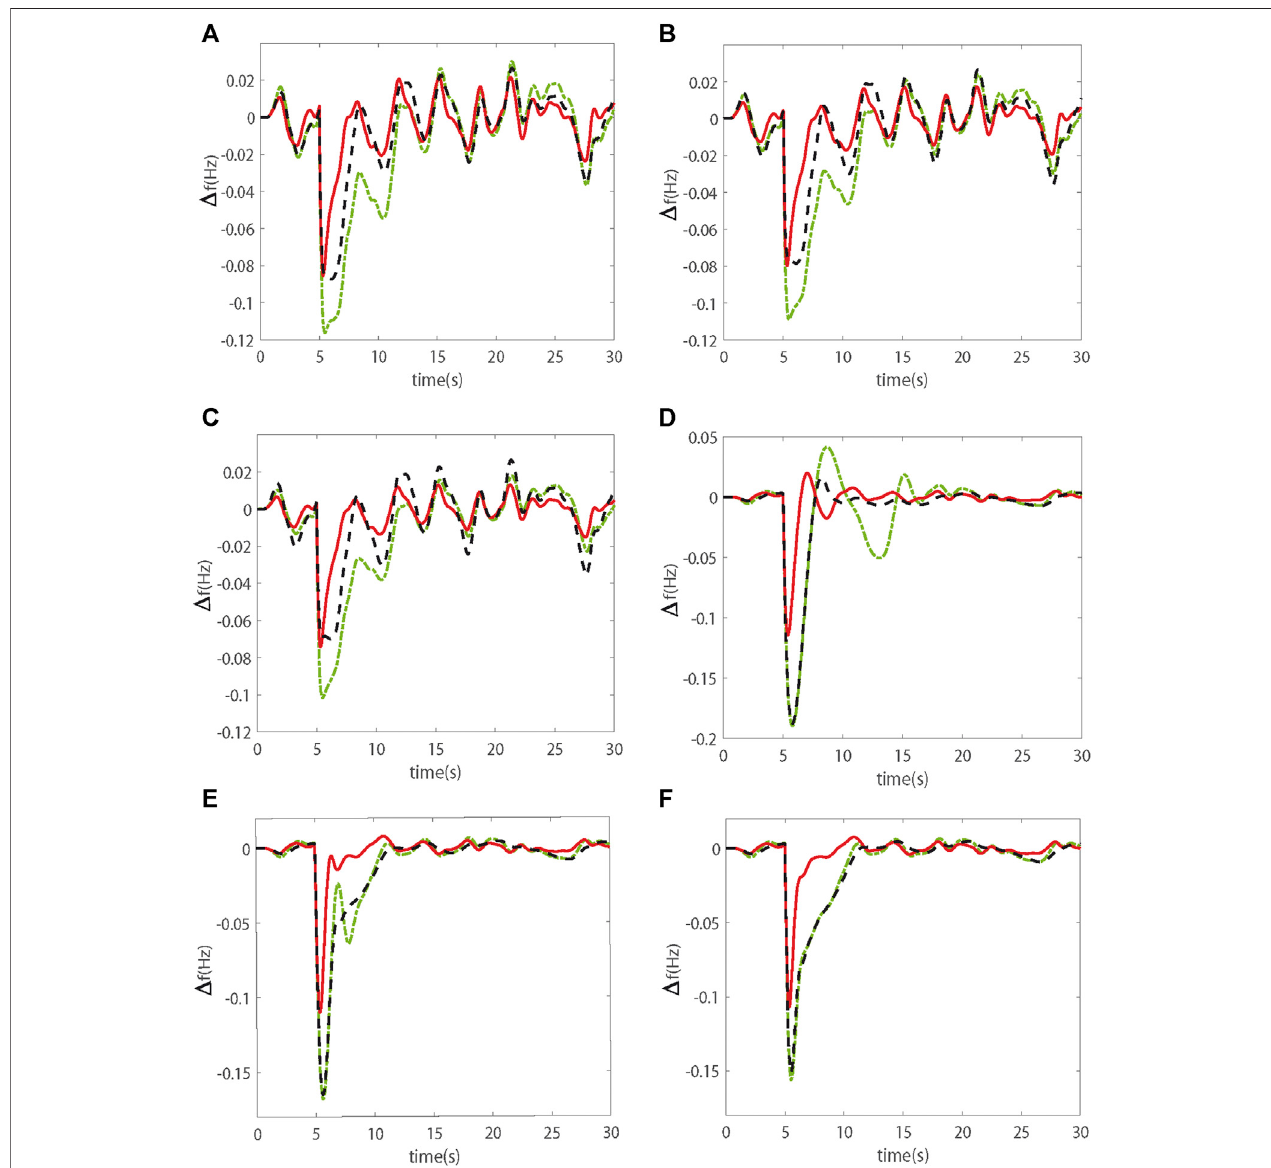
FIGURE3| Frequencydeviationfromdifferentcontrolmethods underthree scenarios invariable lowandhigh windspeed, (A) isScenario1inlowwindspeed, (B) is Scenario 2 in low wind speed, (C) is Scenario 3 in low wind speed, (D) is Scenario 1 in high wind speed, (E) is Scenario 2 in high wind speed, (F) is Scenario 3 in high wind